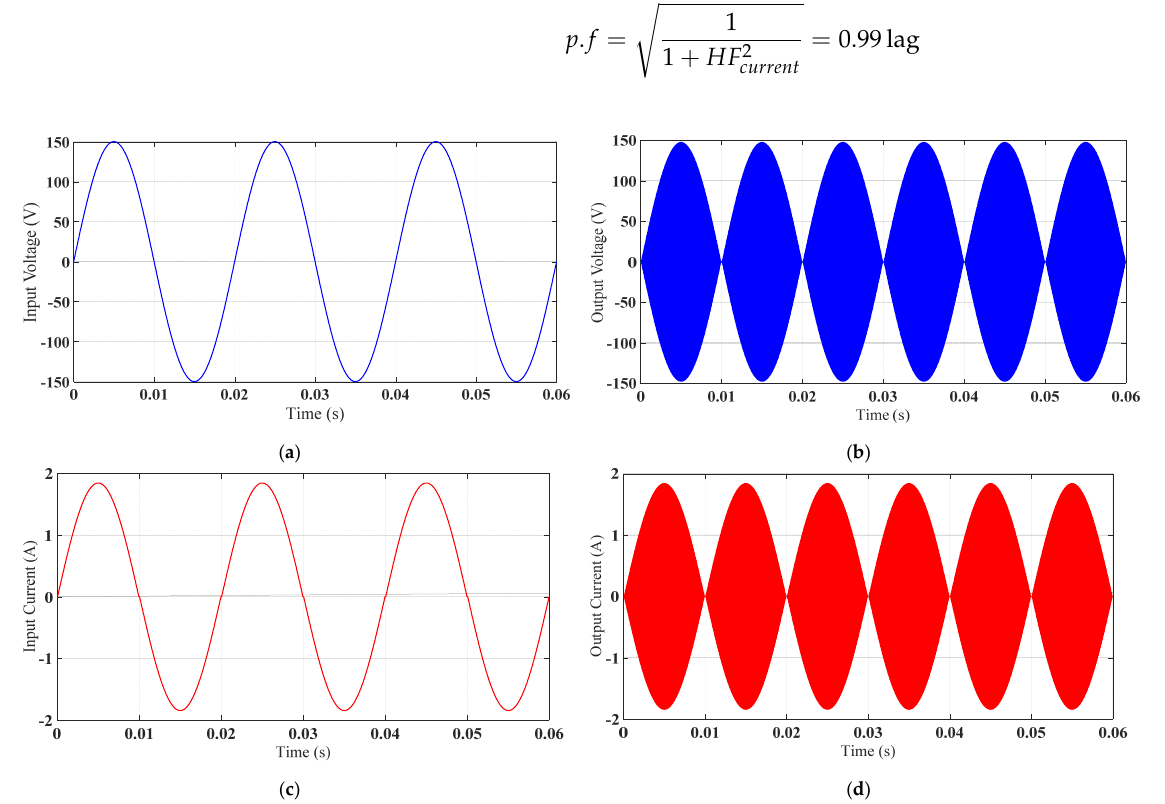
Appl. Sci. 2021 , 11 , x FOR PEER REVIEW